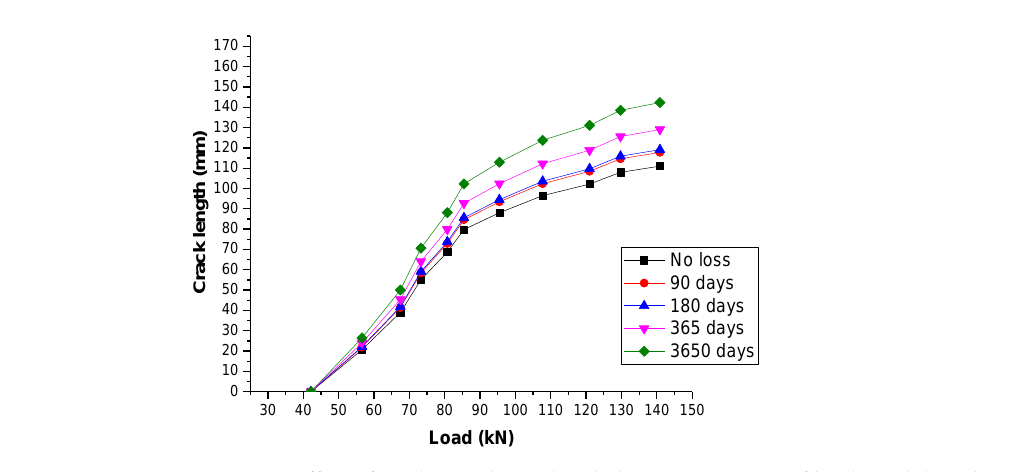
Figure 10. Effect of total time-dependent behaviour in terms of load-crack length response. Table 5. Ultimate crack length due to time-dependent behaviour in days.